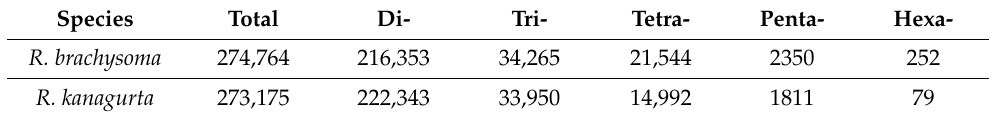
Table 4. Frequency of SSR motifs identified in R. brachysoma and R. kanagurta . Species